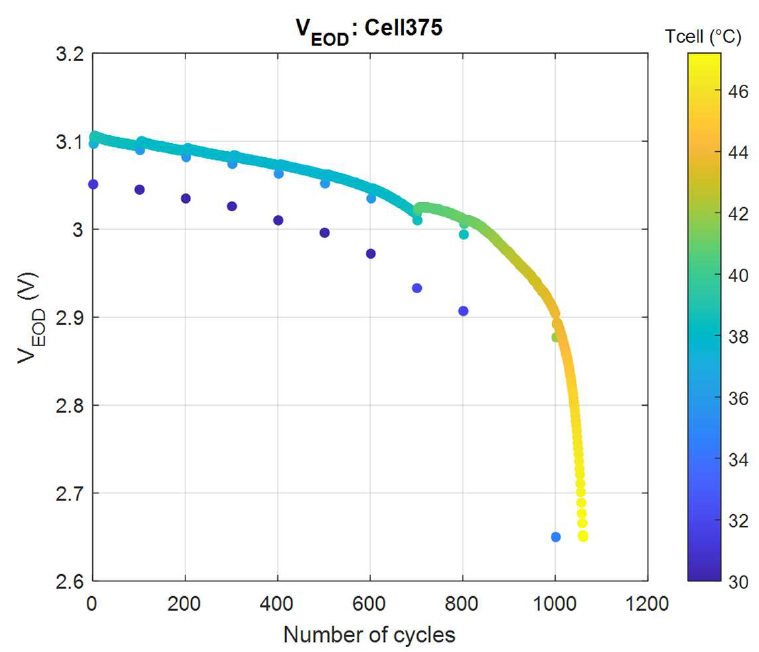
Figure 6. A zoom on one of the end-of-discharge voltages shown in Figure 5 .